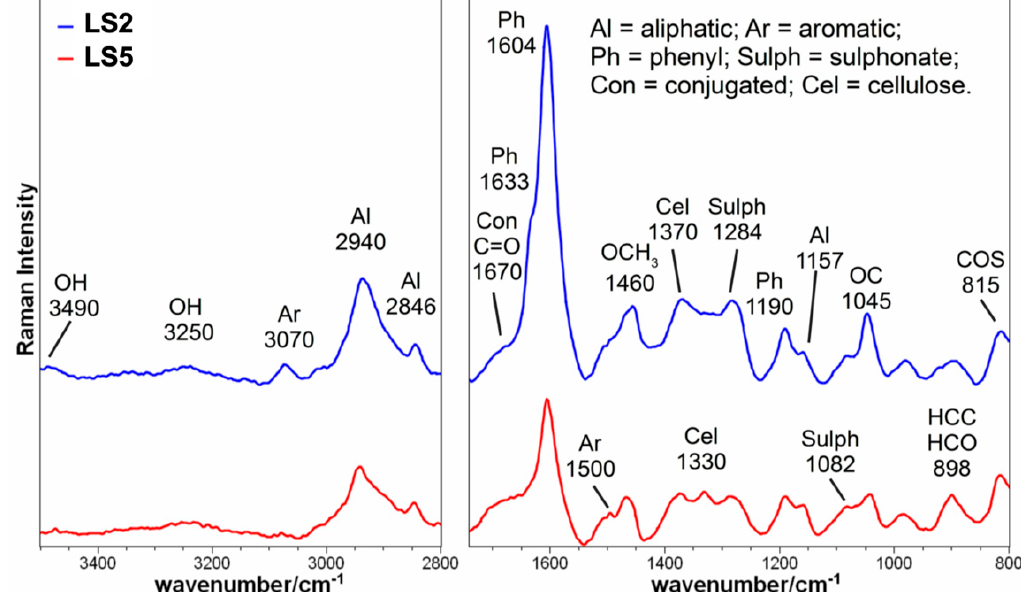
Figure 2. FT-RAMAN spectra of lignosulfonates LS2 and LS5. Table 2. Main bands observed in the Raman spectra of humates LS2 and LS5. S = strong; m = medium; w = weak; v = very; sh = shoulder.